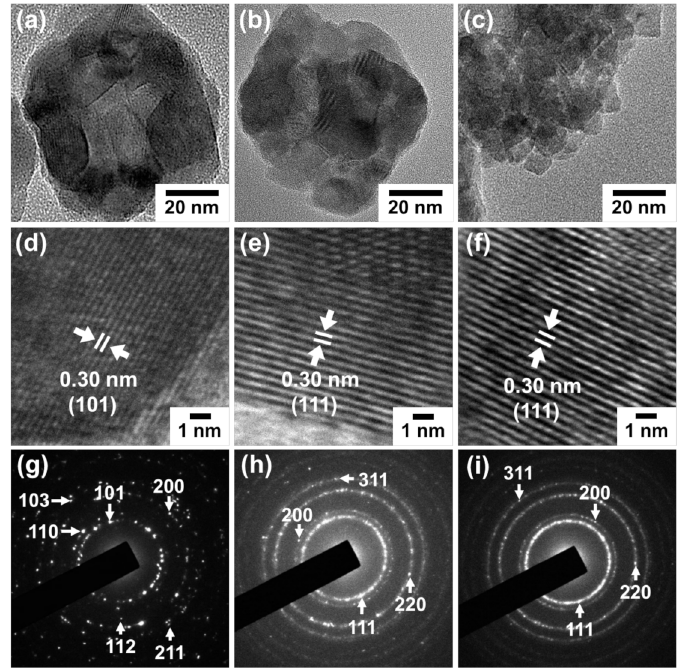
Figure 5. TEM images ( top ), HRTEM images ( middle ), and SAED patterns ( bottom ) of the YSZ nanospheres: ( a , d , g ) 3YSZ, ( b , e , h ) 8YSZ, and ( c , f , i ) 30YSZ.